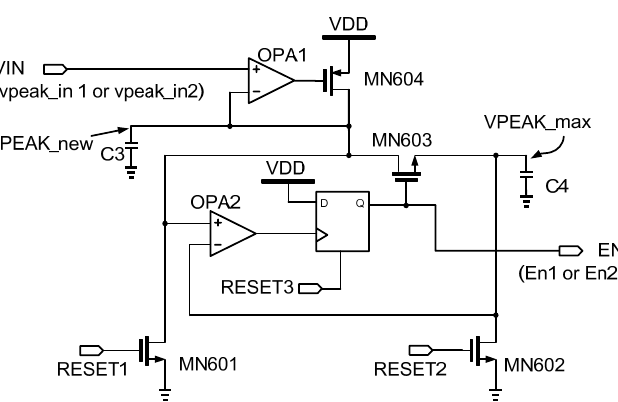
Figure 14. Schematic of the peak detector.